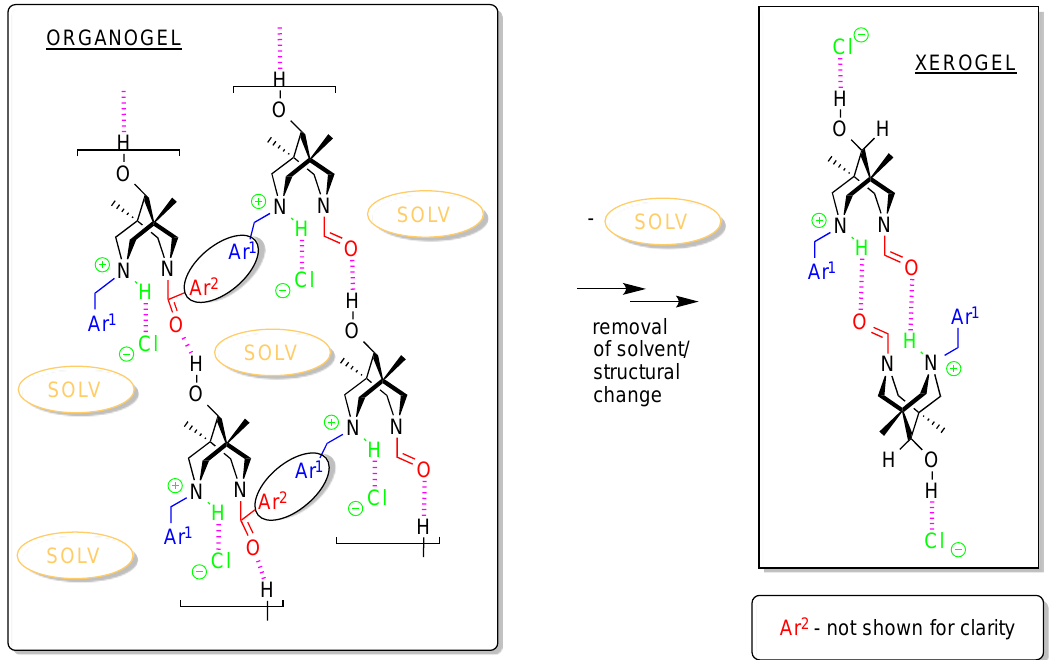
Scheme 4. Schematic representation of the structural changes upon solvent removal from the benzenogel.